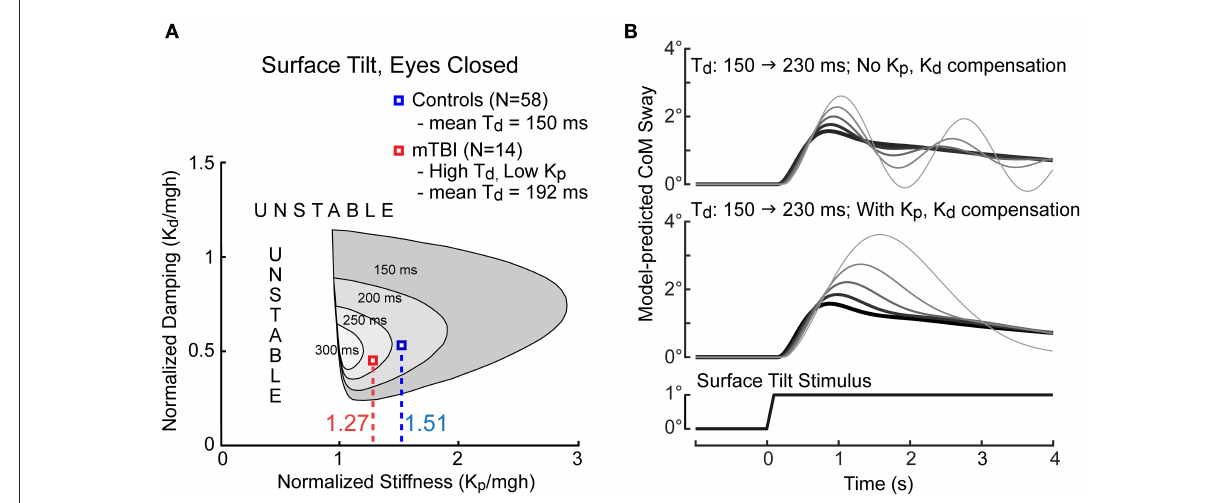
FIGURE9 Illustration of constraints on balance system stability as a function of time delay and motor activation normalized stiffness and damping parameters. (A) The CSMI model-predicted regions of stability (gray regions) shrink with increasing system time delay. The mean normalized stiffness values for control subjects (blue) and for the 14 mTBI subjects (red) with particularly long time delays and low stiffness in the SS/EC condition are labeled. (B) Model simulations of sway responses to 1 ◦ tilts of the stance surface show the effects on the sway response as time delay increased from 150ms (thickest dark trace) to 230ms in increments of 20ms in conditions where stiffness and damping parameters remained fixed (upper graph) and when normalized stiffness and damping were decreased to compensate for the increasing time delay (lower graph). Prominent oscillatory sway behavior is eliminated by lowering stiffness and damping when time delays are larger but at the expense of having a larger peak sway responses. Simulations performed using MATLAB Simulink version R2019b.